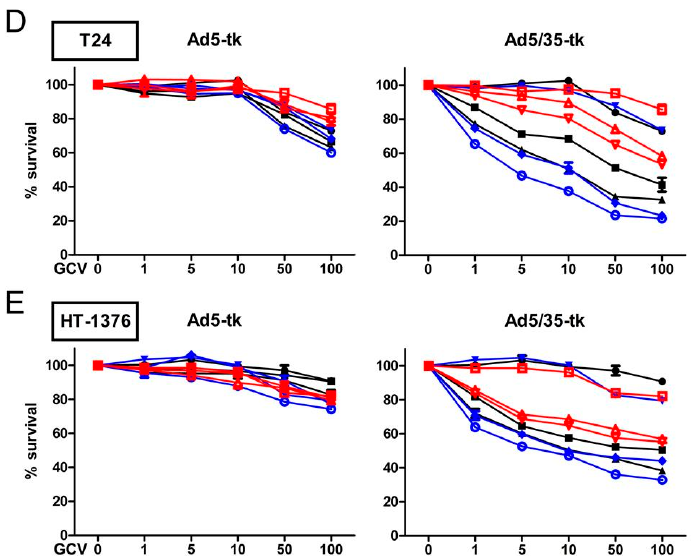
Figure 6. Ad5/35-tk-mediated enhancement of in vitro cytotoxicity in bladder cancer cells. CD46-overexpressing (CD46), CD46-suppressed (shCD46), or control EJ bladder cancer cells (veh) were seeded into 24-well plates and cultured overnight. Subsequently, the cells were either left untransduced or were transduced with Ad5-tk or Ad5/35-tk at the indicated MOIs of 5 and 20. The following day, increasing concentrations of GCV were added and an MTT in vitro proliferation assay was performed five days post-infection. Bladder cancer cells used in this experiment are EJ ( A ), 5637 ( B ), J82 ( C ), T24 ( D ), and HT-1376 ( E ). The error bars represent SEM. Statistics: p < 0.05 by two-way ANOVA.